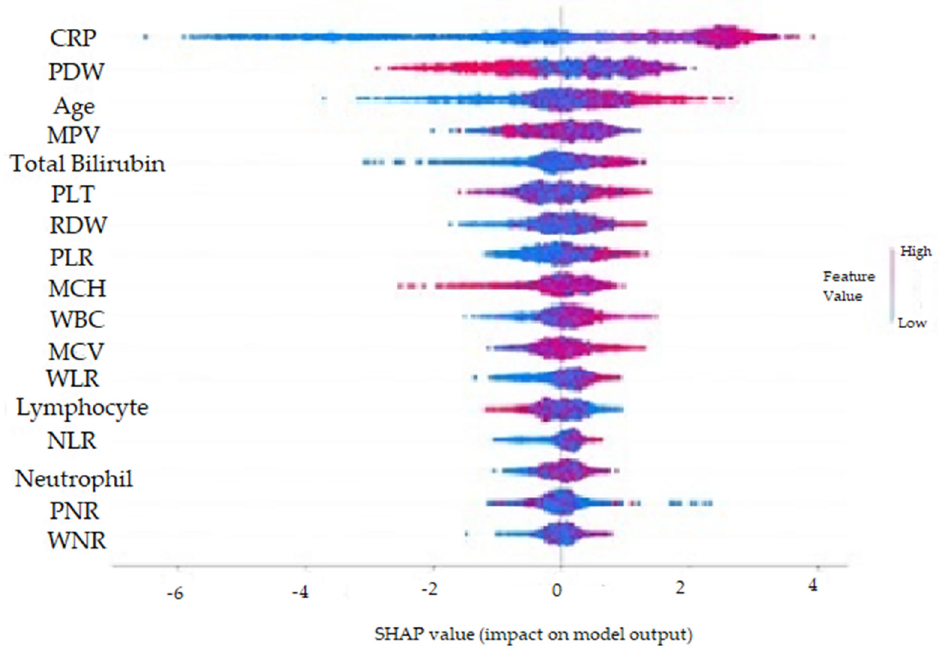
Figure 4. Feature importance plot according to normalized SHAP values for perforated AAp.